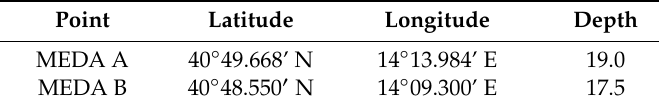
Figure 5. ( a ) Map of the Gulf of Naples and location of the study site. ( b ) Zoom on the study area. The positions of point W (offshore Pozzuoli’s Gulf), Monitoring and Environmental Data Units, MEDA-A and MEDA-B, are also depicted. The brown contour line defines the remediation site boundaries. Table 5. Geographical information of MEDA units.